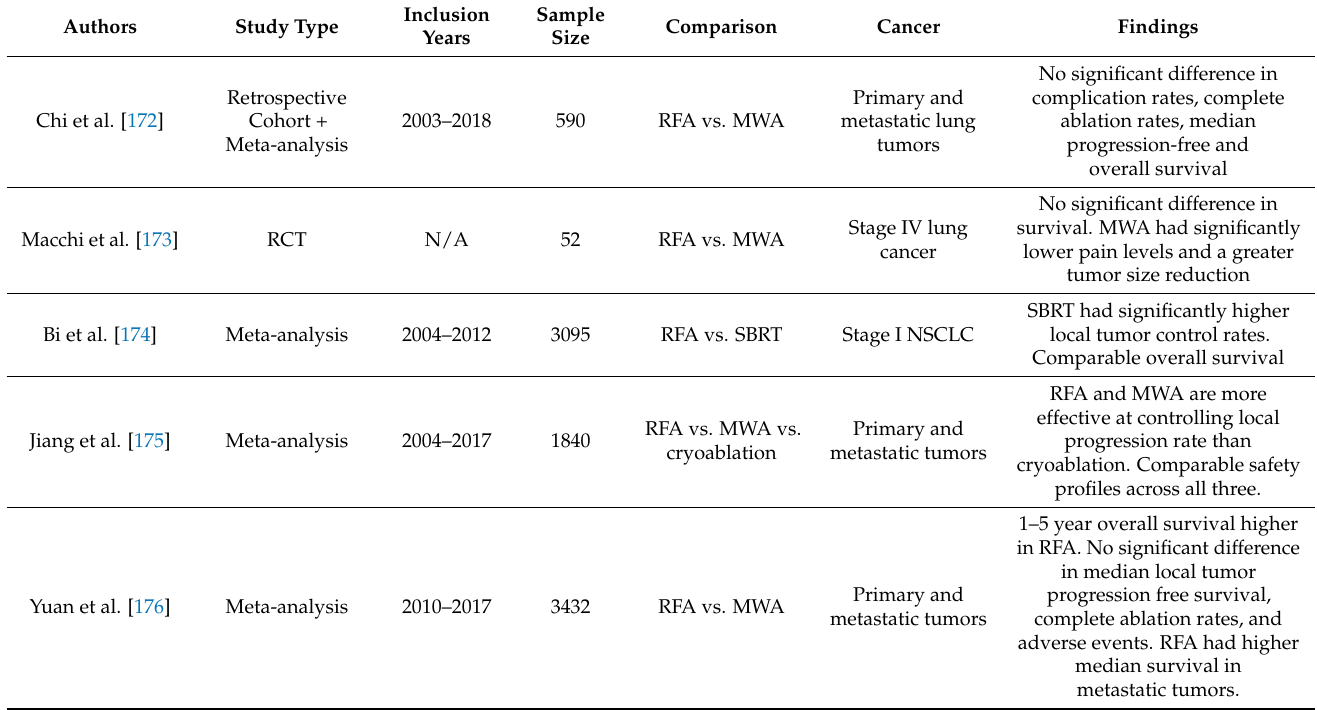
Table 5. Comparison of ablation modalities for lung